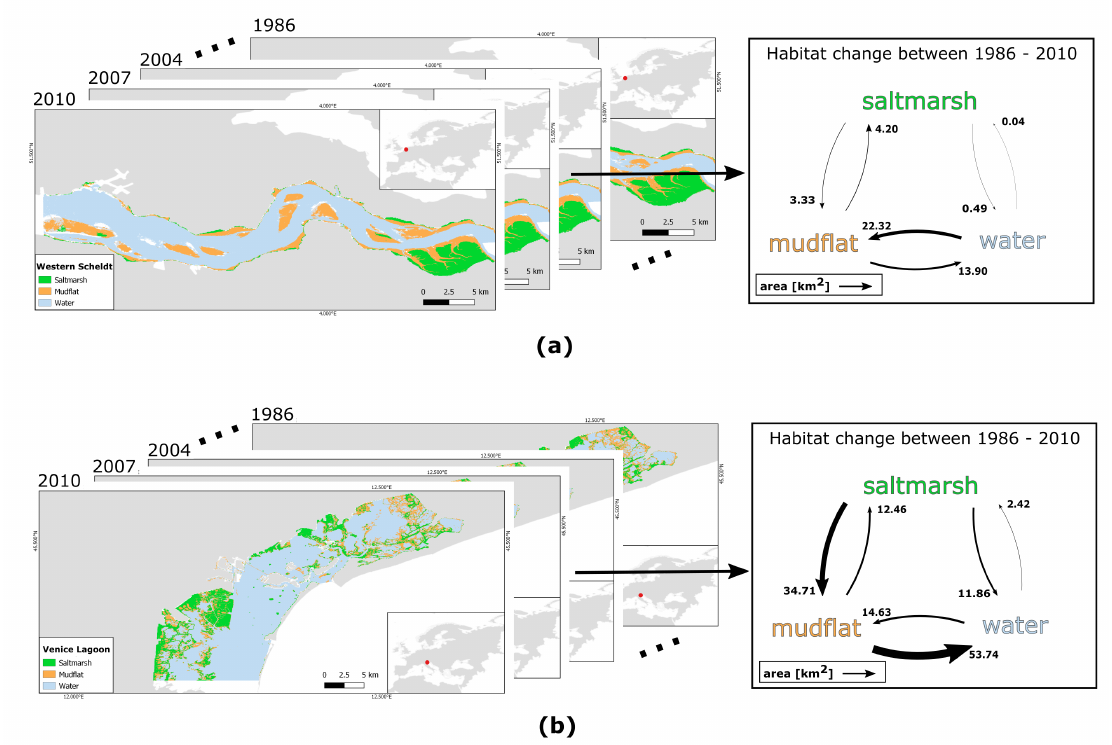
Figure 6. Time series of the classification results for ( a ) the Western Scheldt and ( b ) the Venice Lagoon from 1986 (representing the years 1985, 1986, 1987) to 2010 (representing the years 2009, 2010, 2011). On the left time series resulting from the decision tree (DT) classification of saltmarsh, mudflat, and water. The gray areas indicate land and the white areas indicate ocean around the study site. On the right, habitat change between the classes saltmarsh, mudflat, and water from 1986 to 2010 is shown. The black arrows indicate the size of the area becoming another